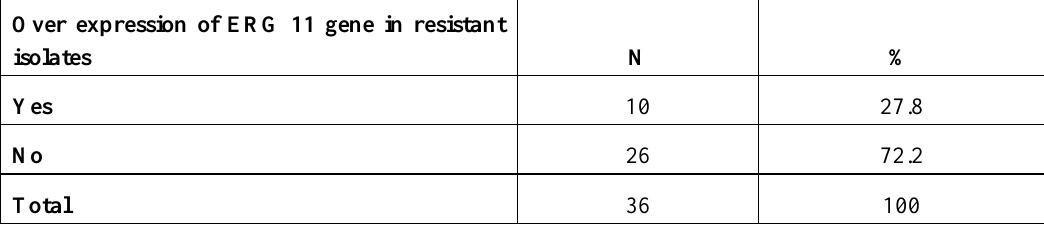
Table 5. Prevalence of overexpressed ERG-11gene in resistant isolates.